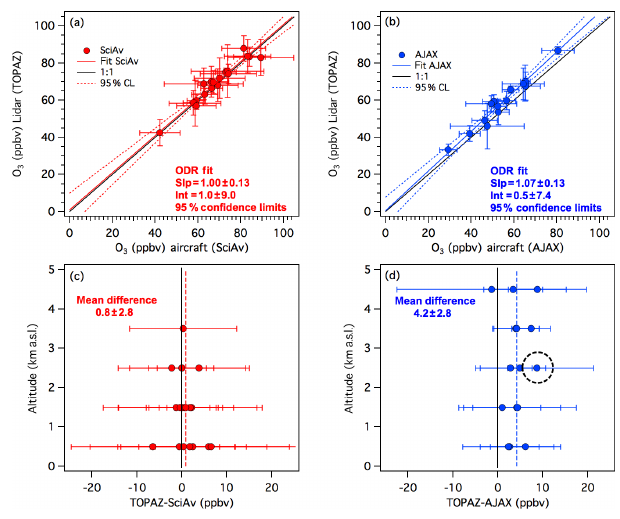
Figure 15. (a, b) Scatterplots comparing the TOPAZ lidar retrievals to in situ O 3 measurements from seven SciAv Mooney and three NASA Alpha Jet flights, respectively, averaged over 1km vertical bins. The error bars show the standard deviations of the 1km col- umn means. (c, d) Differences between the 1km mean TOPAZ and aircraft measurements from (a) and (b) plotted as a function of al- titude. The vertical dashed lines show the mean differences. The dashed circle in (d) corresponds to the dashed oval in Fig. 13b (see